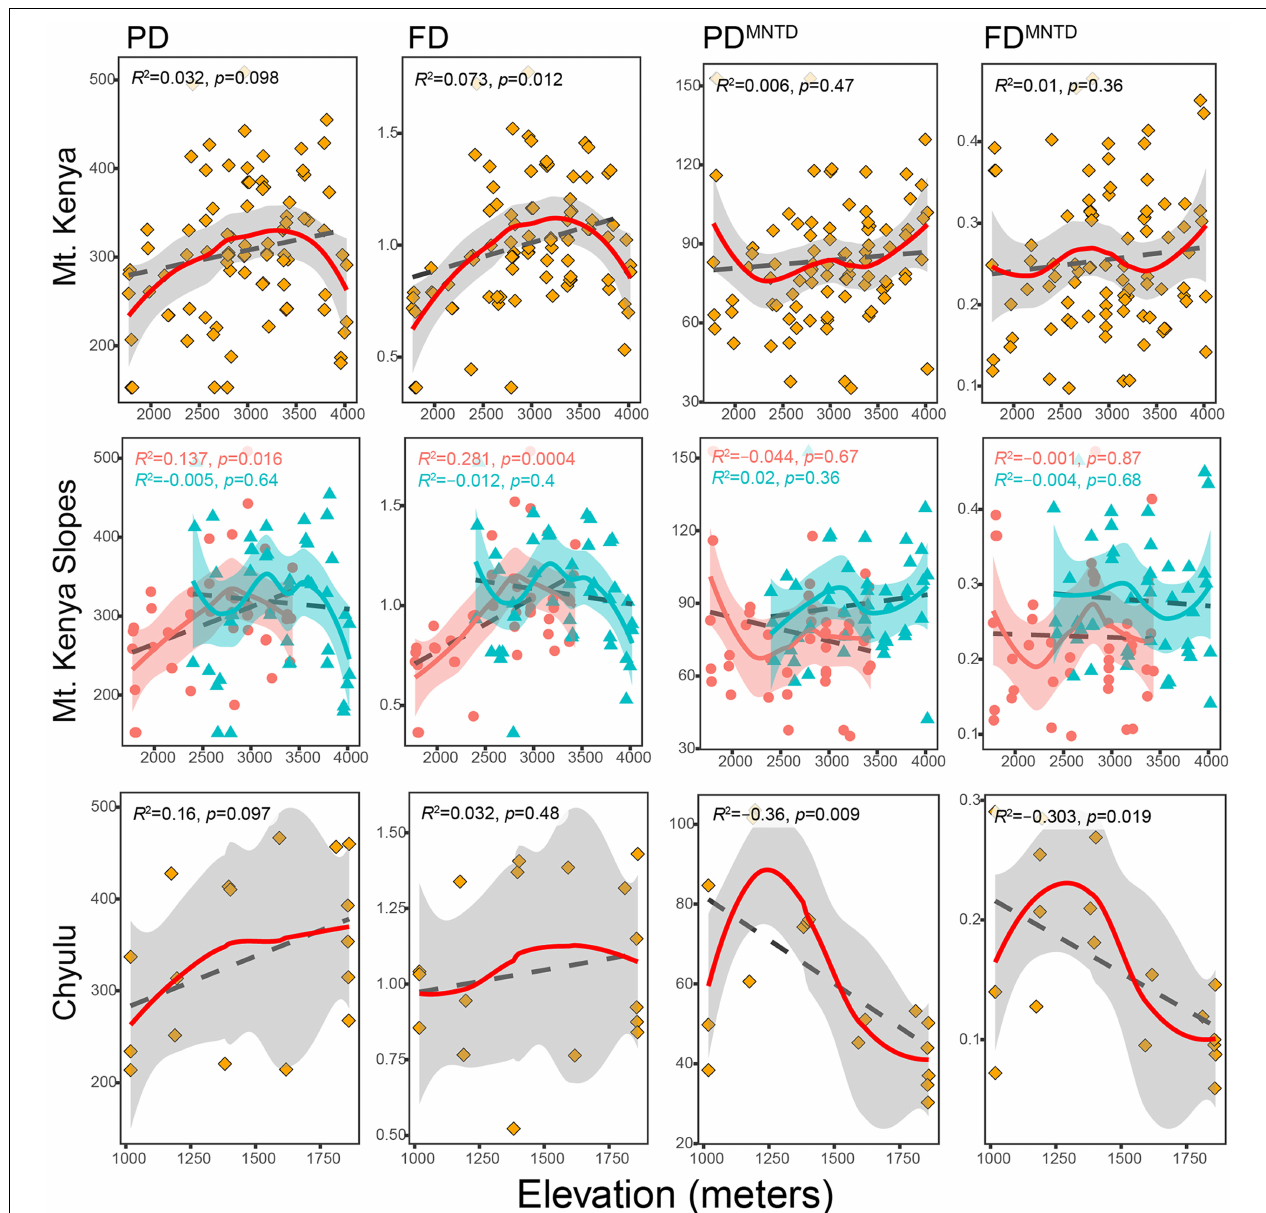
FIGURE 2 | The distribution of phylogenetic and functional diversity and divergence indices ( y -axes) along elevational gradients ( x -axes) between the sites and indices. Points represent traplines and lines represent regression lines—local polynomial (solid colored lines) and generalized linear model (GLM; black dashed lines). In the Mt. Kenya plots, light red-colored dots represent Chogoria traplines while the dark shade of cyan triangular points represents Sirimon traplines.